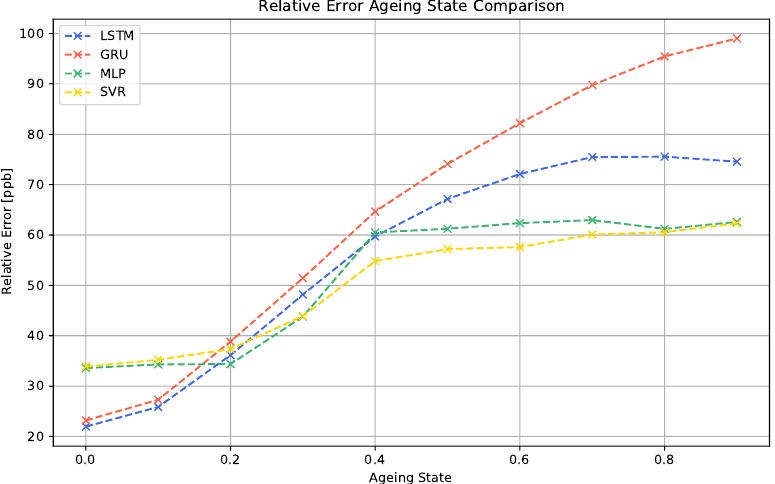
Figure 14. Comparison of the relative error across the different regression models for different ageing